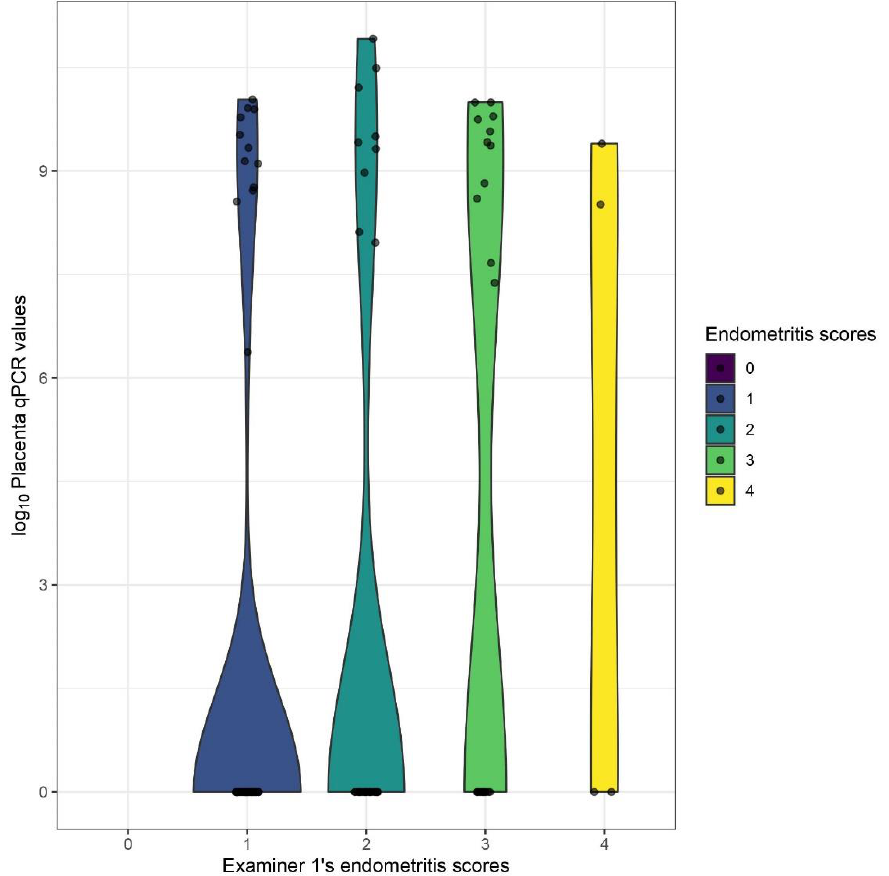
Figure 7. Violin plots depicting the distributional differences of log10 placental qPCR values between different endometritis grades as evaluated by examiner1.